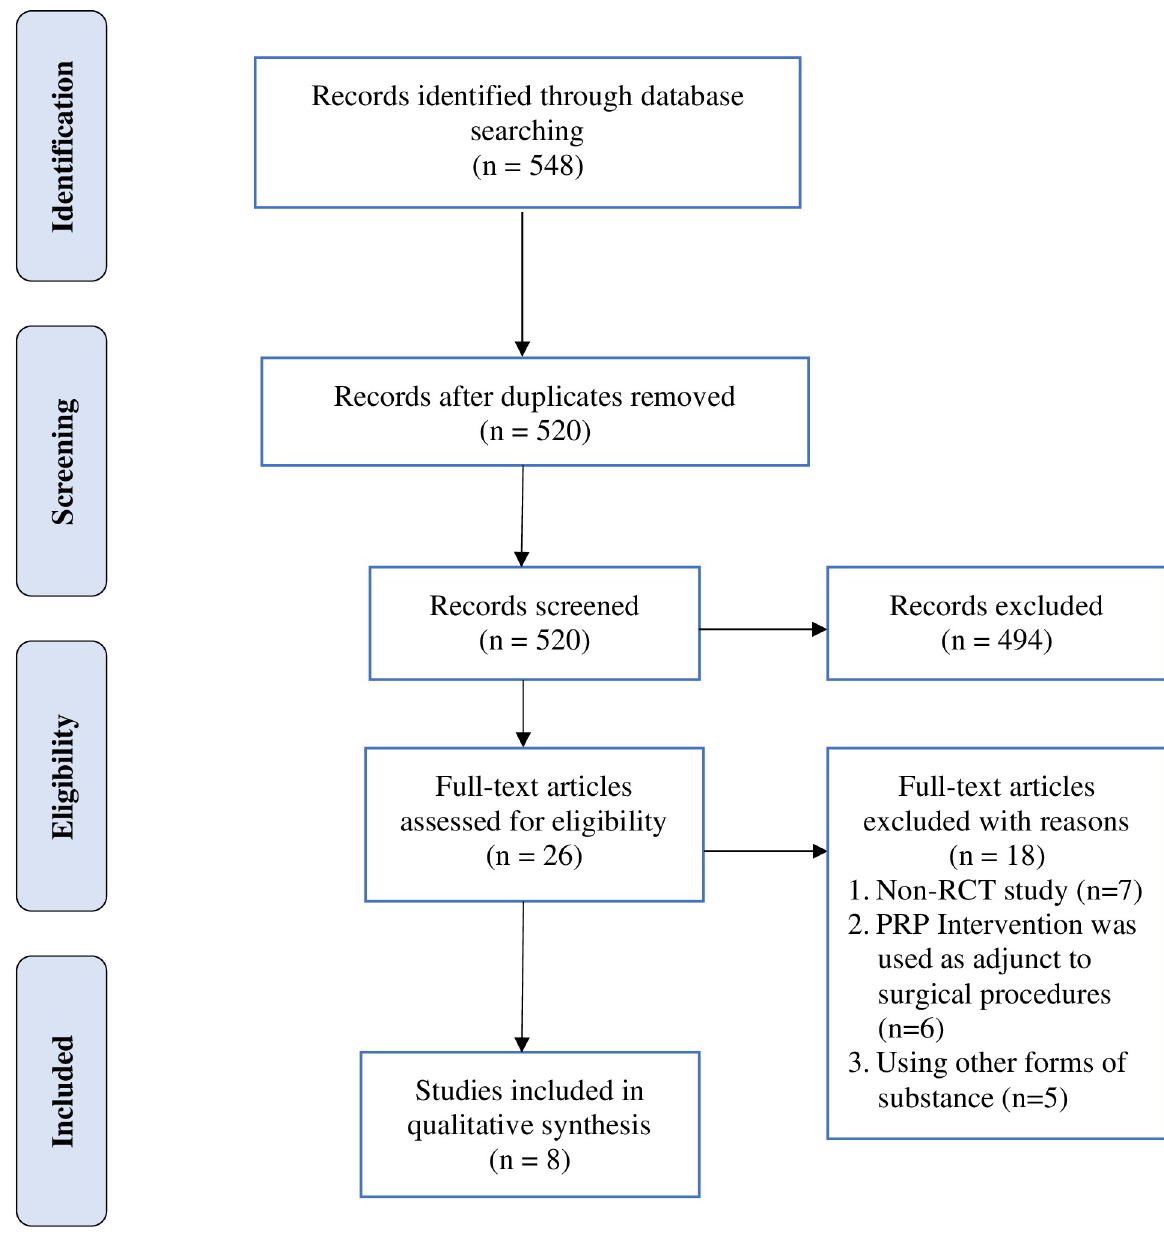
Fig 1. Flow diagram for selected